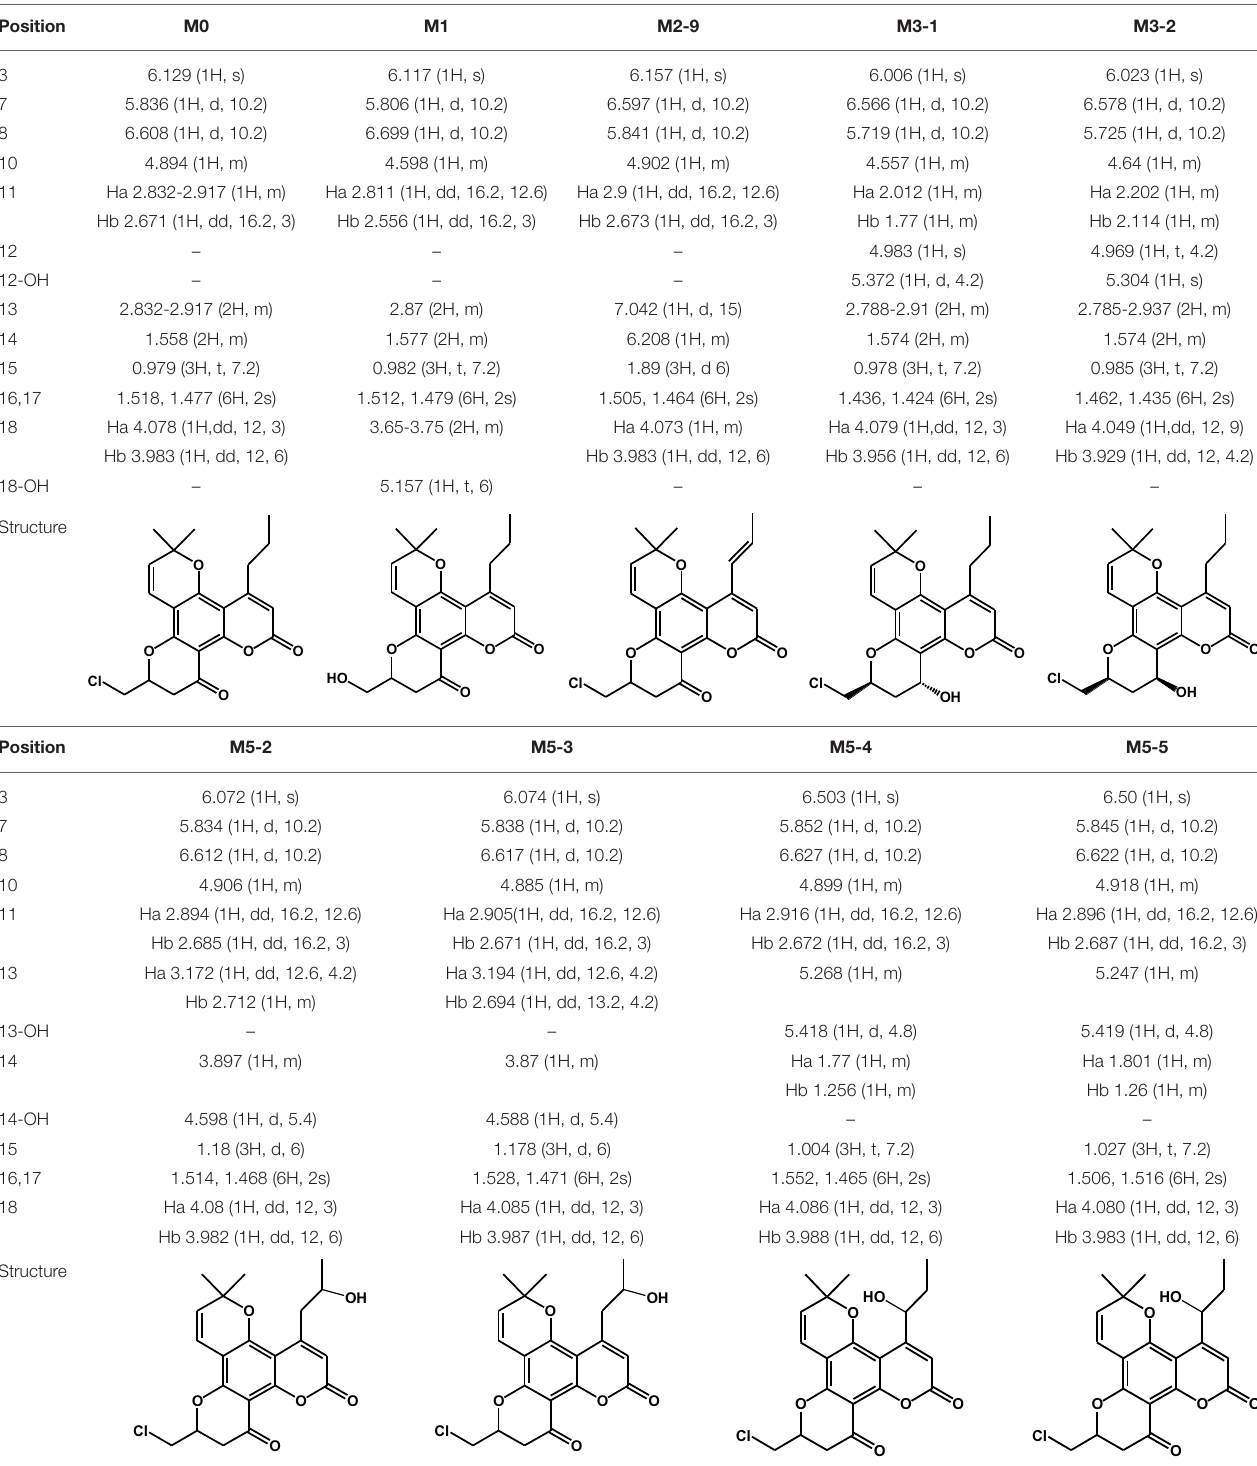
TABLE 3 | 1 H-NMR spectra data for F18 and its major metabolites.